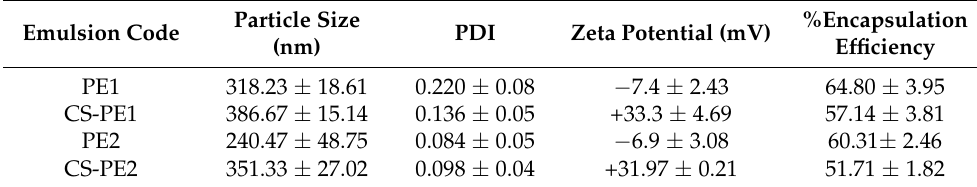
Table 3. Characteristics of the PLGA and chitosan-coated PLGA nanoparticles prepared by point prediction using response surface DOE. Particle size is the representation of the diameter of the particle (nm). Data = mean ± std ( n =